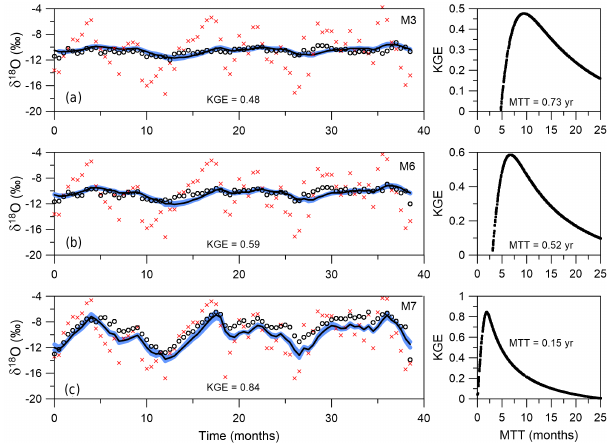
Figure 5. Fitted results and Monte Carlo simulations of the fitted parameters of the exponential model (EM) used to simulate the δ 18 O streamflow composition in the catchments: (a) M3; (b) M6; and (c) M7. The open circles represent the observed isotopic com- position in streamflow; the red crosses represent the isotopic com- position in precipitation; the black line represents the best simulated isotopic composition in streamflow according to the KGE objec- tive function; and the blue shaded area corresponds to the 5–95% confidence limits of the possible solutions from the MTT fitting pa- rameters within the range of behavioral solutions, i.e., solutions that yield at least 95% KGE. Panels on the right represent the explored parameter range for the MTT parameter and the KGEs associated with each of them.